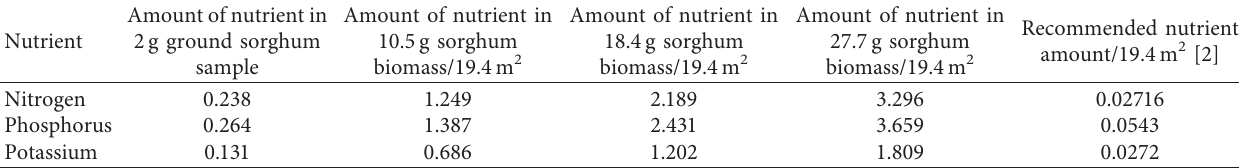
Table 3: Macronutrient composition of the dry sorghum residues used in the